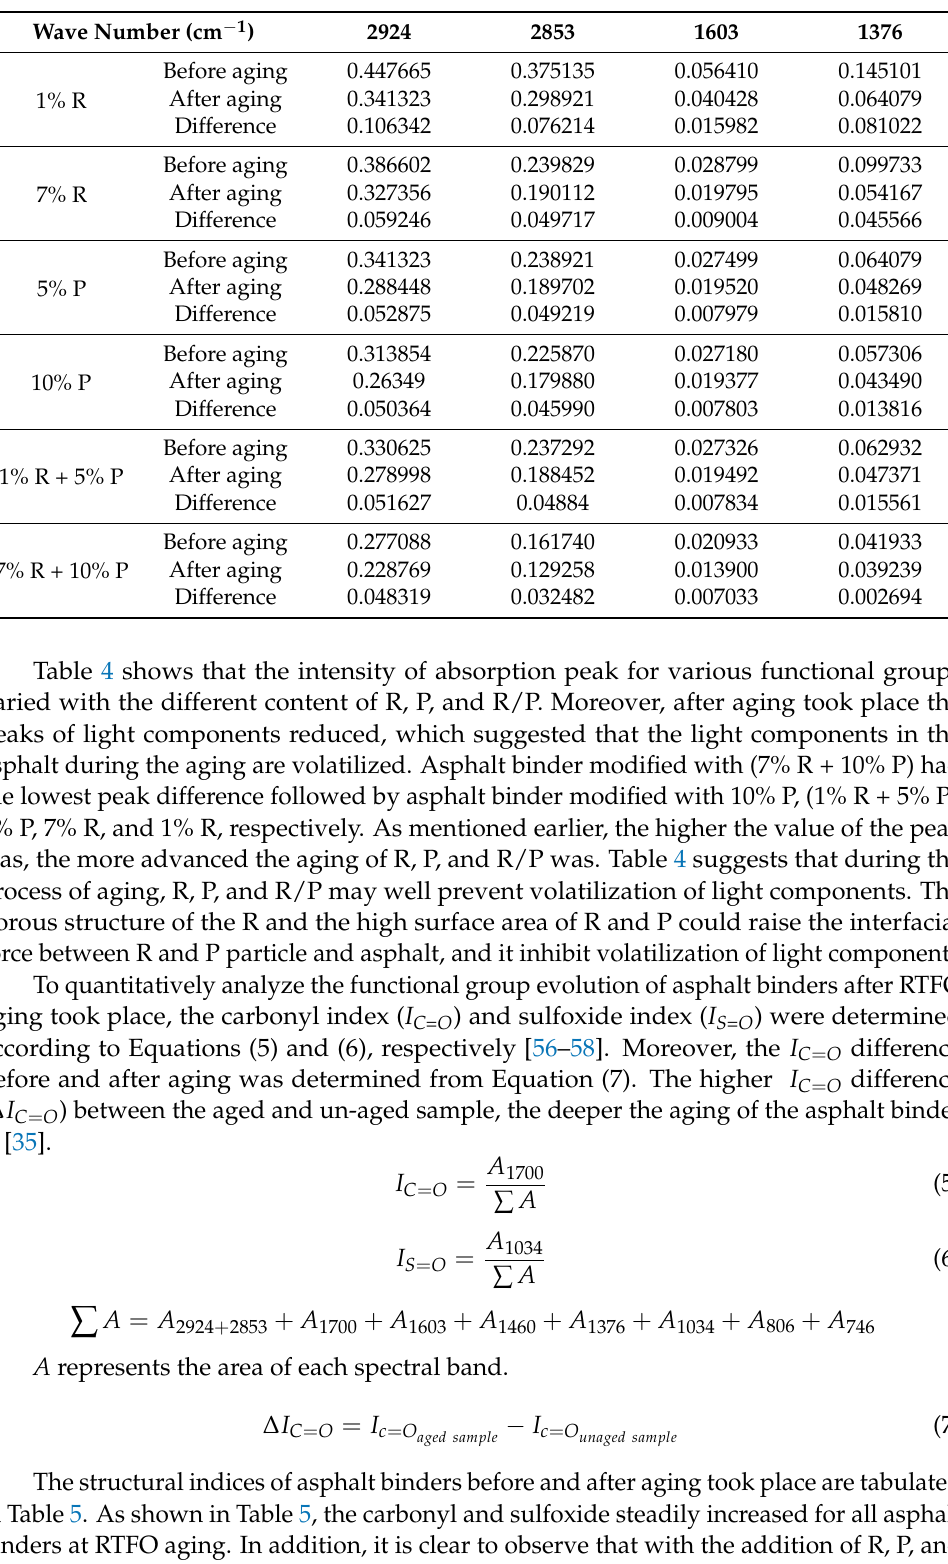
Table 4. Peak values for the featured functional groups of modified asphalt